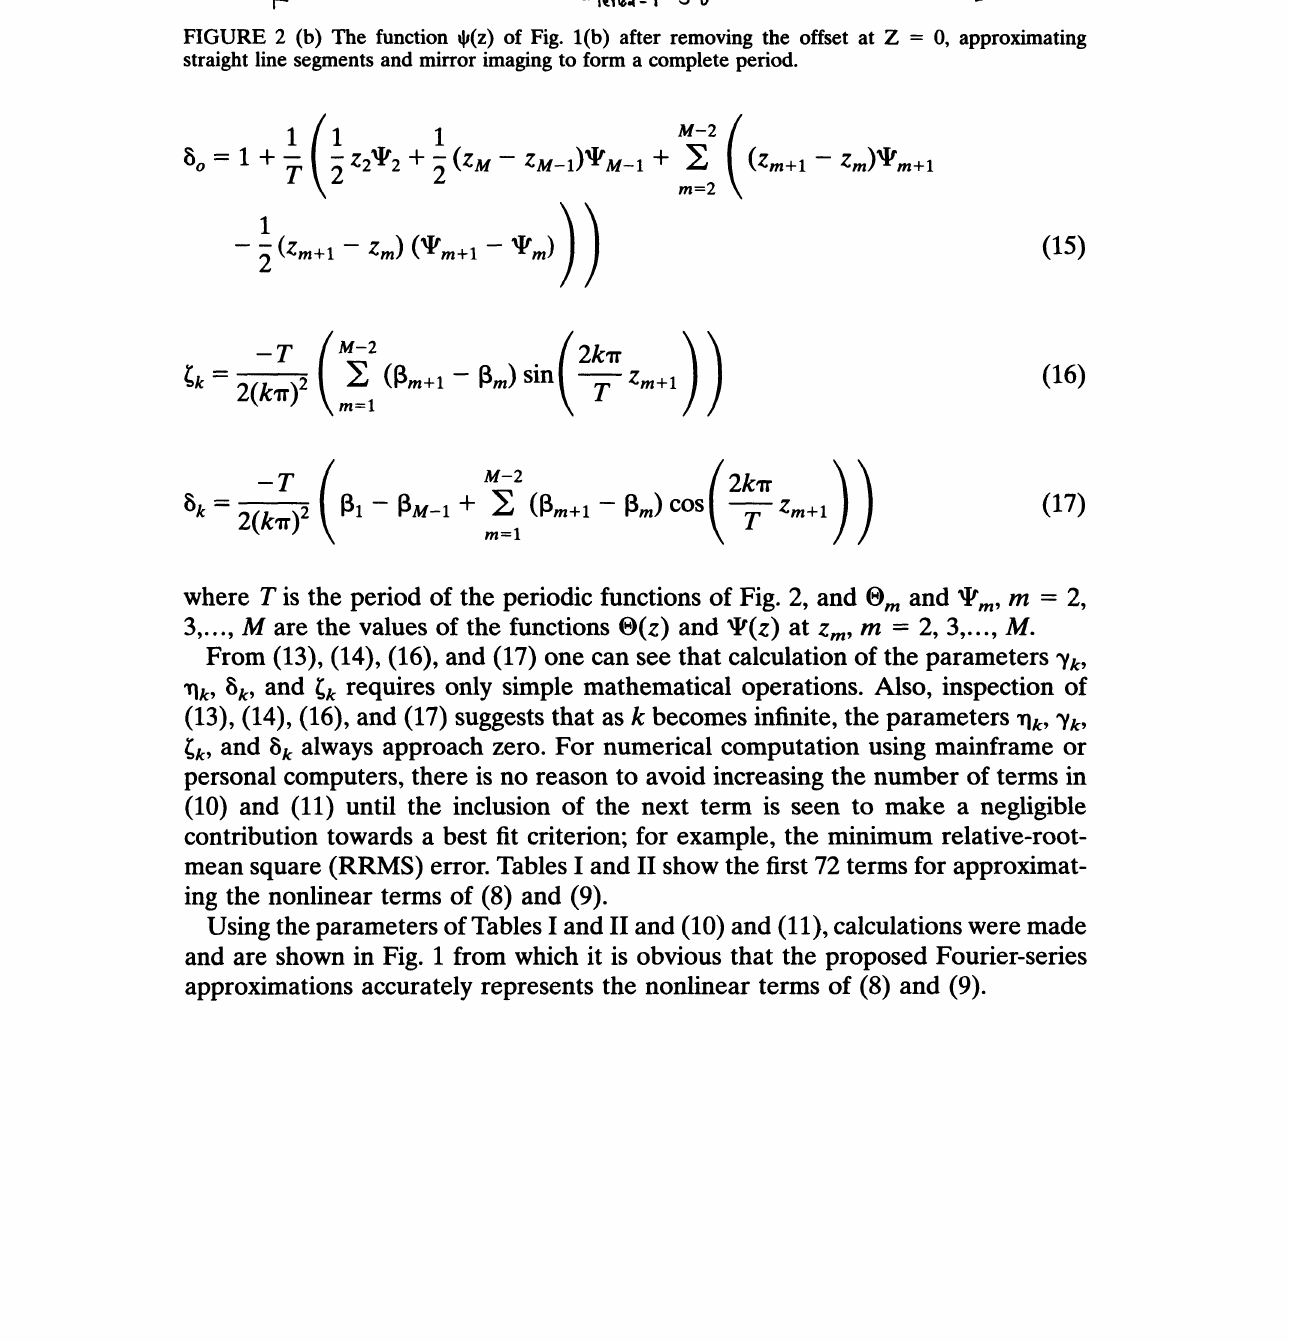
FIGURE 2 (b) The function (z) of Fig. l(b) after removing the offset at Z 0, approximating straight line segments and mirror imaging to form a complete